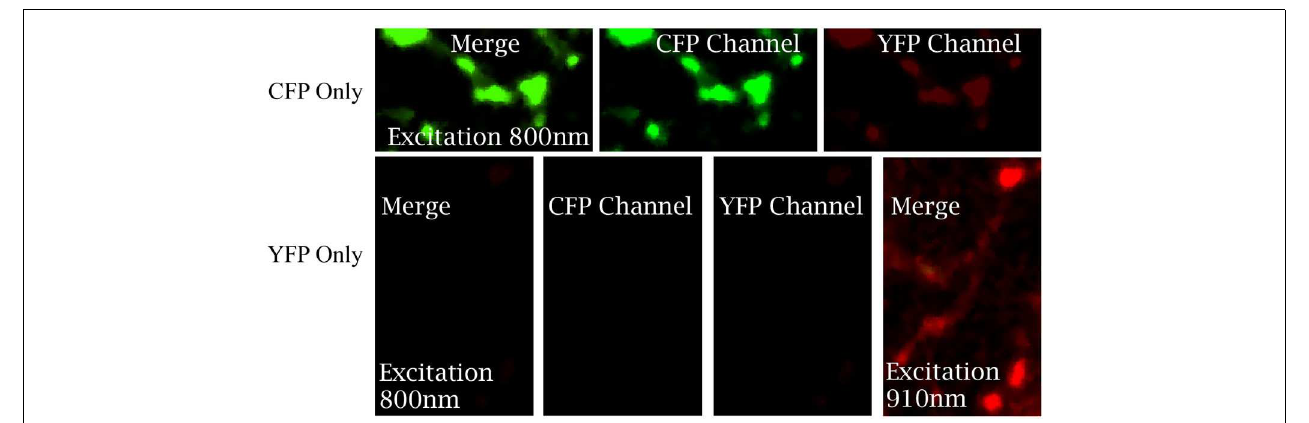
transfected with LSL-actin-CFP or LSL-actin-YFP at EP14.The labeled neuron was imaged with two-photon microscopy at EP18. Images were taken under different wavelength excitation indicated in the